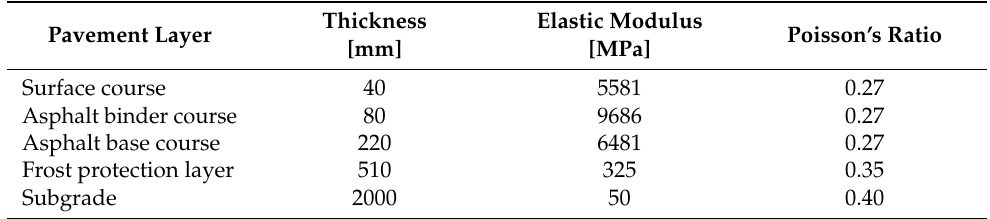
Table 1. Information about pavement structure and